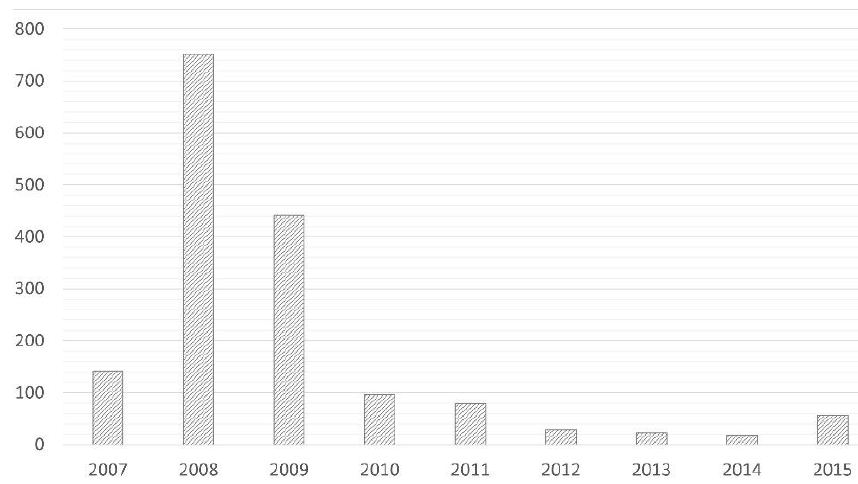
Figure 2. Number of photographs per year in the Panoramio sample.